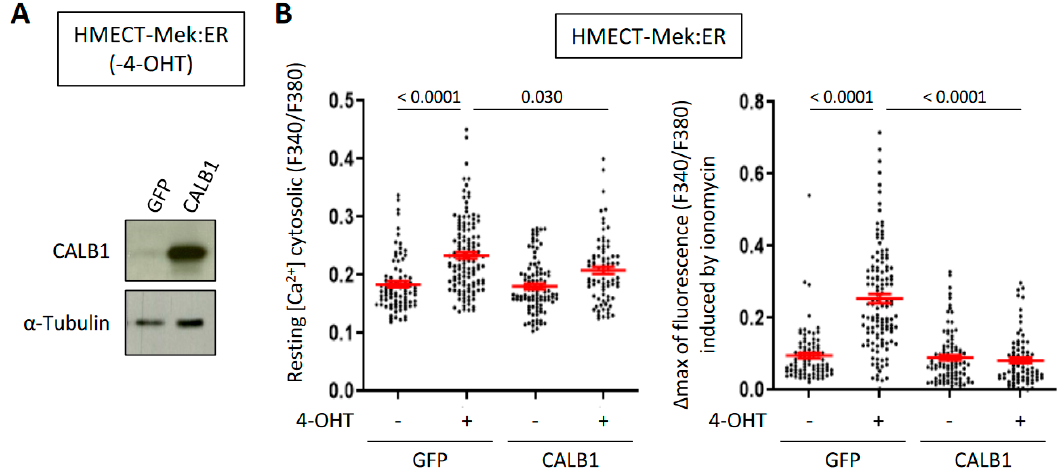
Figure 4. CALB1 overexpression buffers increased Ca 2+ levels induced by oncogene activation in HMECT. ( A ) CALB1 protein level was assessed by Western Blot in HMECT-Mek:ER (without 4-OHT) infected with a vector encoding CALB1 or the corresponding GFP control vector. α -Tubulin protein level was assessed as a loading control. ( B ) Ca 2+ levels were measured with the ratiometric probe Fura2 in HMECT-Mek:ER inducible oncogene and CALB1 or the corresponding GFP control vector, with or without 4-OHT treatment. Resting cytosolic Ca 2+ concentration was evaluated as a stable fluorescent ratio before stimulation ( left panel), and the size of Ca 2+ intracellular stocks was estimated as the Ca 2+ peak amplitude obtained after ionomycin stimulation ( right panel). Means +/ − SEM of 3 independent experiments are presented. Kruskal–Wallis test was performed, and p -values are indicated. Three days after 4-OHT treatment, GFP- 4-OHT n = 85 or + 4-OHT n = 126, CALB1- 4-OHT n = 99 or + 4-OHT n = 77.